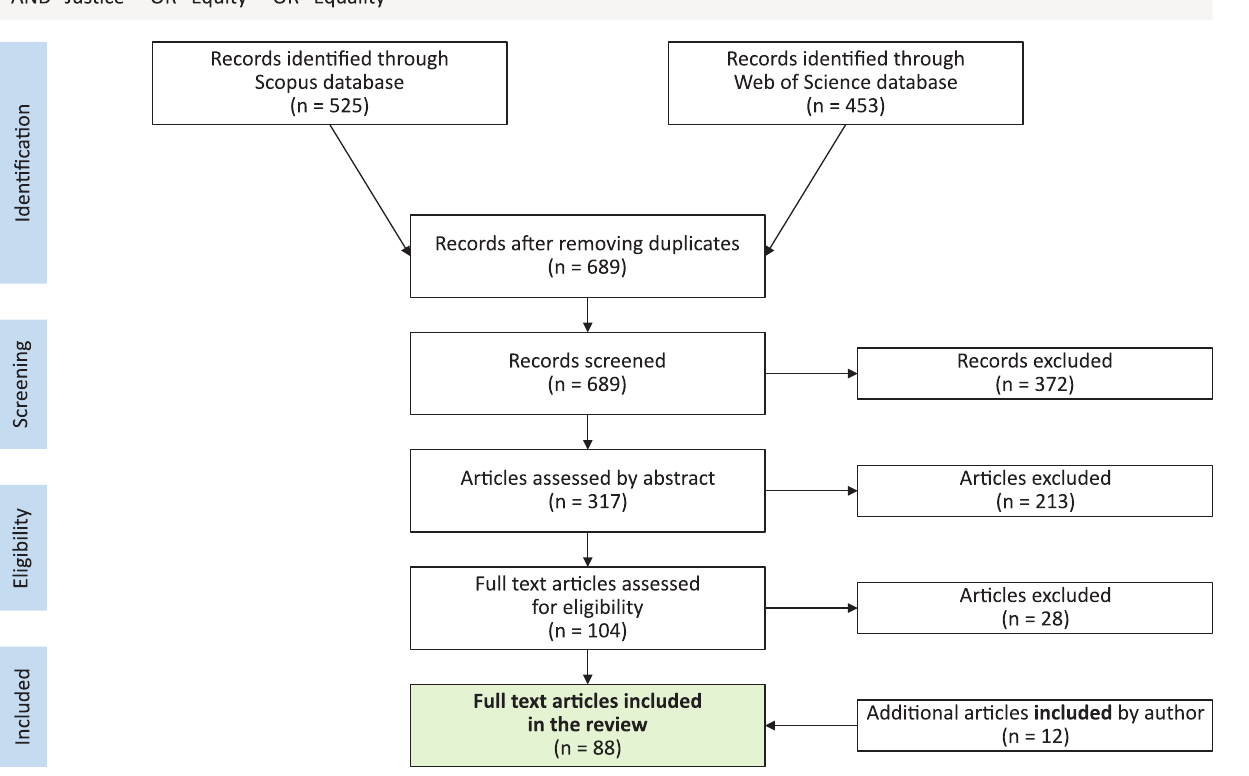
Figure 1. Four‐step selection process of articles to be